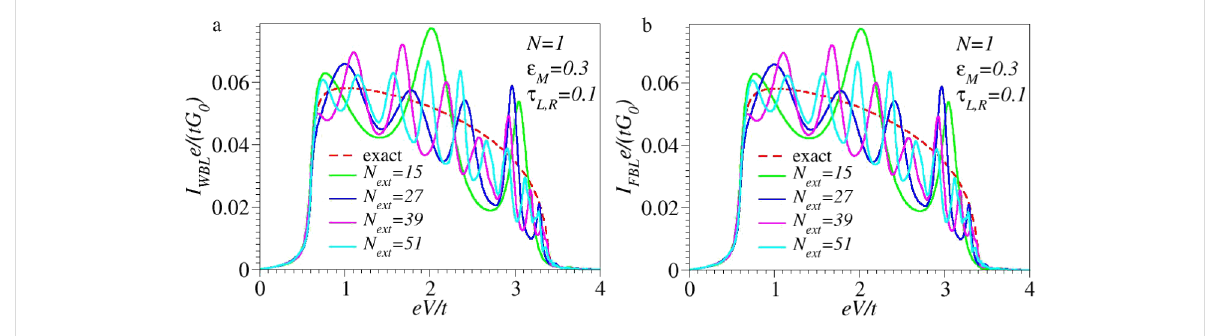
Figure 5: (a) Same as Figure 2b and (b) same as Figure 2c, but using extended molecule sizes up to N ext = 51, that is, including up to 25 extra elec- trode layers at both sides, which is considerably more that present NEGF-DFT approaches can